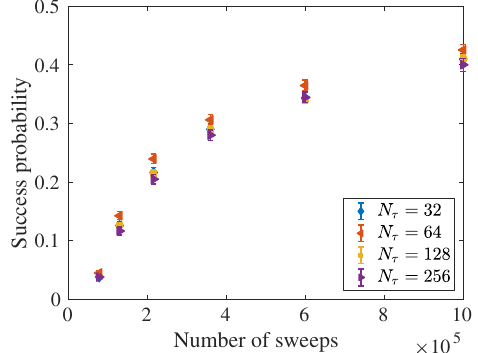
FIG. 11. Performance of SQA as we vary the number of Trotter slices. Shown are CPU simulation results for the success probability for a single logical-planted instance, using 32, 64, 128, and 256 Trotter slices. The success probability is maximized for 64 slices. Error bars give the 95% confidence interval generated by performing 1000 bootstraps.